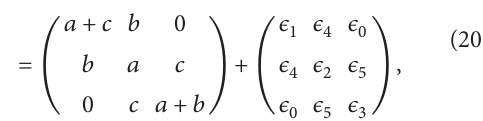
stringent constrains from cosmological